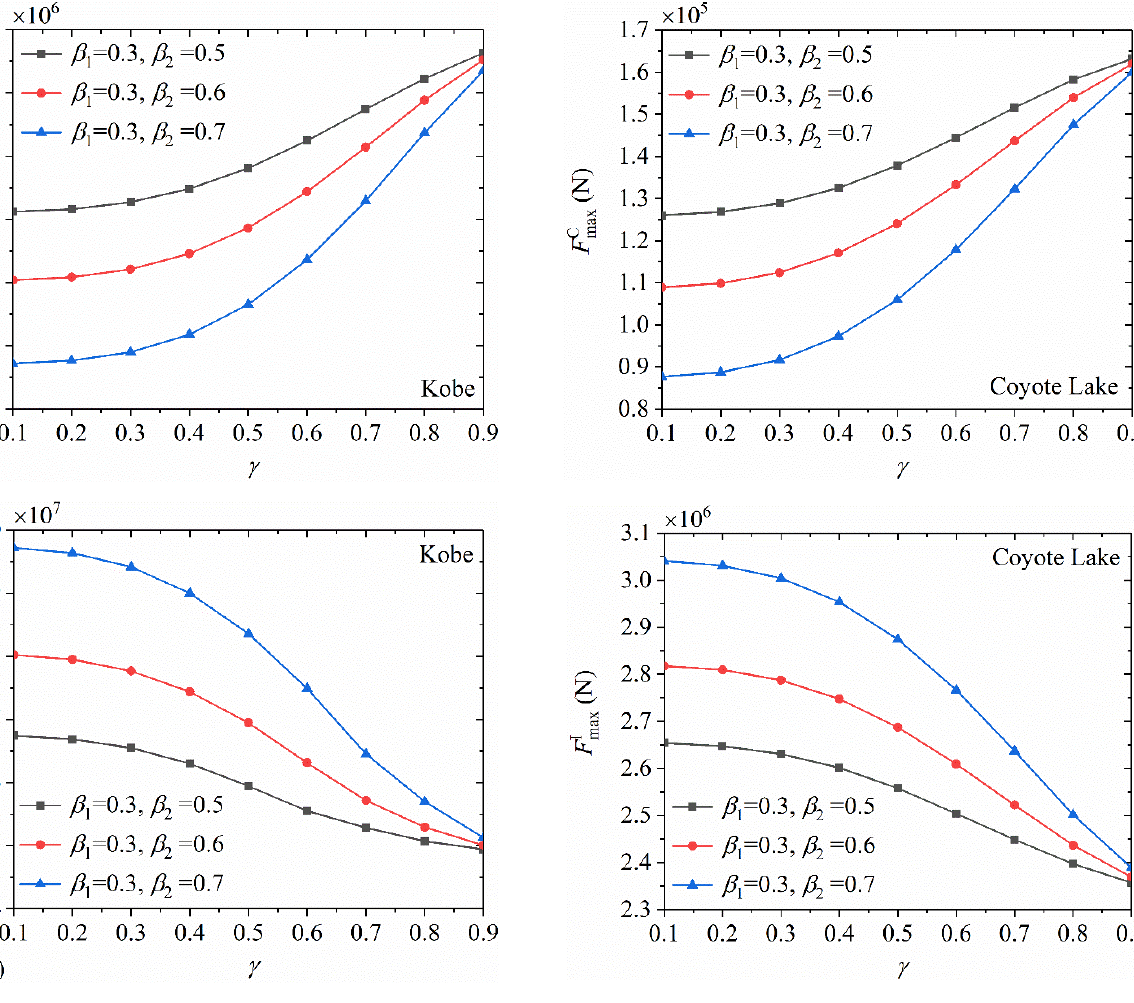
Figure 13. The maximum of the hydrodynamic shear force for the baffle inner radius γ : ( a ) the convective shear F C max ; ( b ) the impulsive shear F I max .